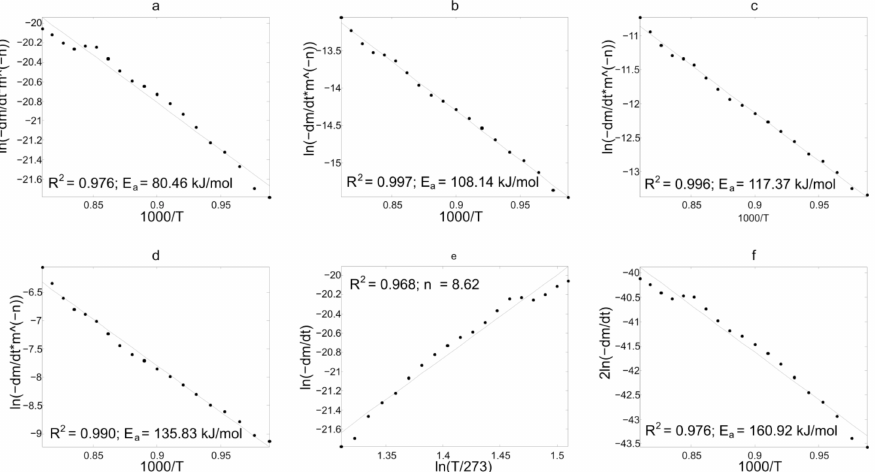
Figure 9. Results of processing of the charcoal gasification TG curve at a heating rate of 50 K min − 1 by different models: ( a ) n = 0; ( b ) n = 0.5; ( c ) n = 2/3; ( d ) n = 1; ( e ) diffusion model; ( f ) pore- diffusion model.